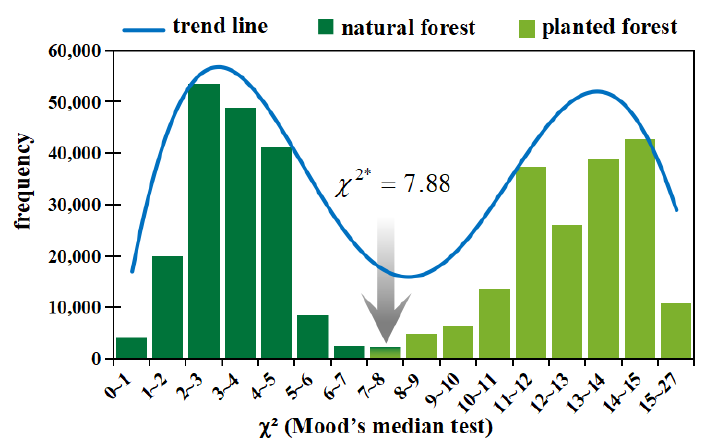
Figure 6. Frequency histogram of the χ 2 statistics of the m-test for all forest objects. With a threshold χ 2 ∗ = 7.88 at the significance level α = 0.005, the histogram is divided into two parts: natural forest (dark green bars) and planted forest (light green bars).